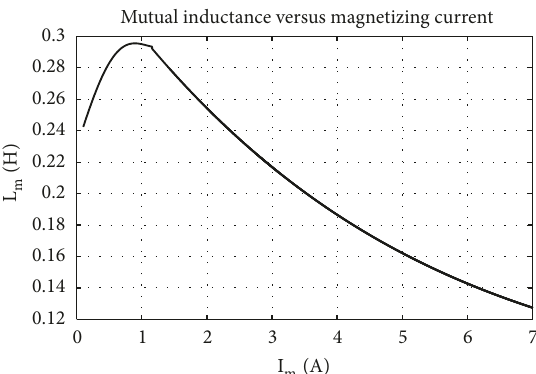
Figure 5: Variation of the mutual inductance with magnetizing